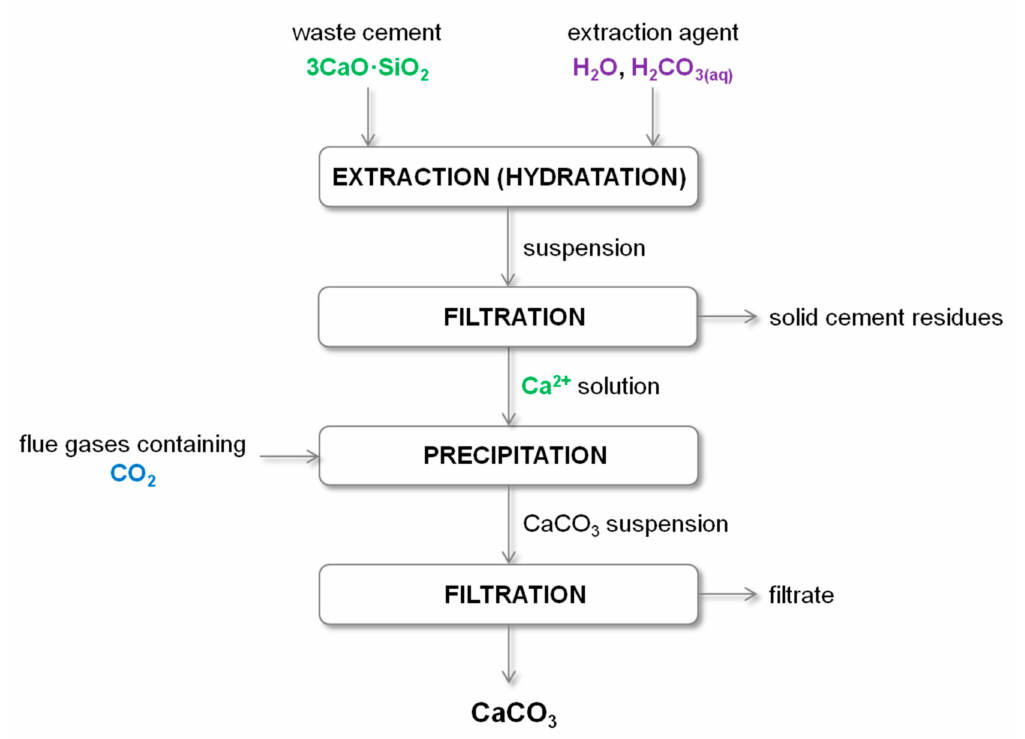
Figure 6. Diagram of the CaCO 3 precipitation process using waste cement and CO 2 from flue gases.